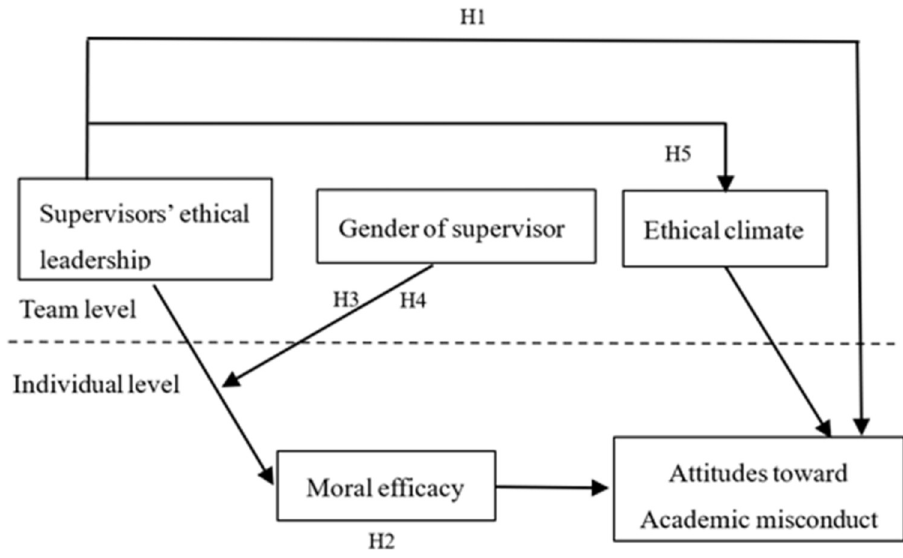
Fig 1. A multilevel mediation model of ethical leadership to academic